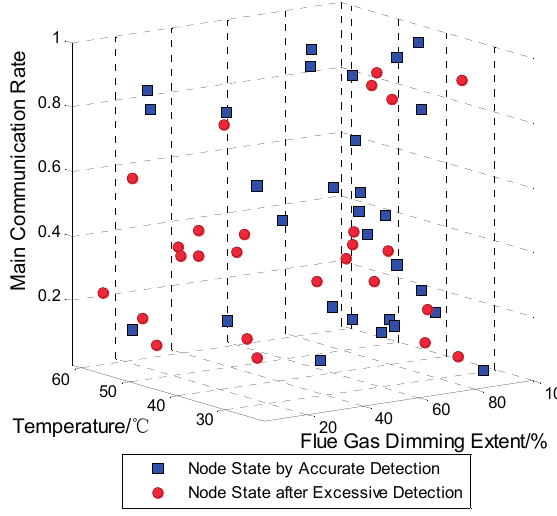
Figure 15. The accuracy rate of diagnosis of PSO test